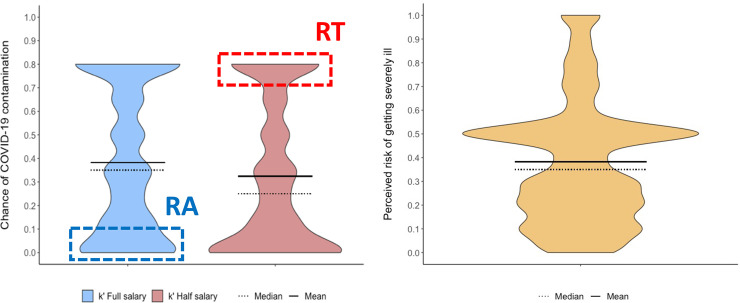
Violin plots in which the horizontal axis depict the density of data distribution.(A) k’ estimate; RA, extreme risk-averse participants (participants always who chose to stay home even at the expense of a full salary offer); RT, extreme risk-taking participants; (participants who always chose leave home even for a half salary offer); (B) Perceived risk of getting severely ill.